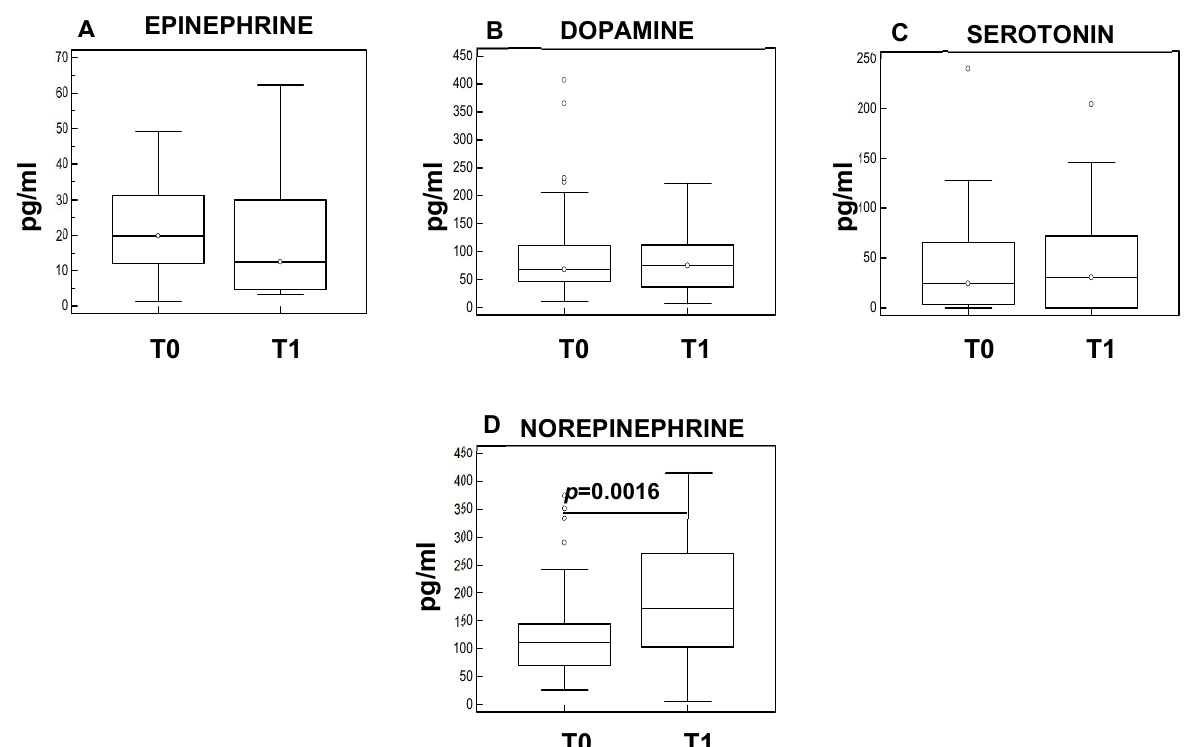
Figure 3. Epinephrin ( A ), dopamine ( B ), serotonin ( C ), and norepinephrine ( D ) plasma concentra- Figure 3. Plasma concentration before (T0) and after the rehabilitation protocol (T1). Summary results tion before (T0) and after the rehabilitation protocol (T1). Summary results are shown in the bar are shown in the bar graphs. The boxes stretch from the 25 to the 75 percentiles; the line across graphs. The boxes stretch from the 25 to the 75 percentiles; the line across the boxes indicates the the boxes indicates the median values; the lines stretching from the boxes indicate extreme values. median values; the lines stretching from the boxes indicate extreme values. Outliers are plotted as Outliers are plotted as individual dots; statistical significance is individual dots; statistical significance is indicated.